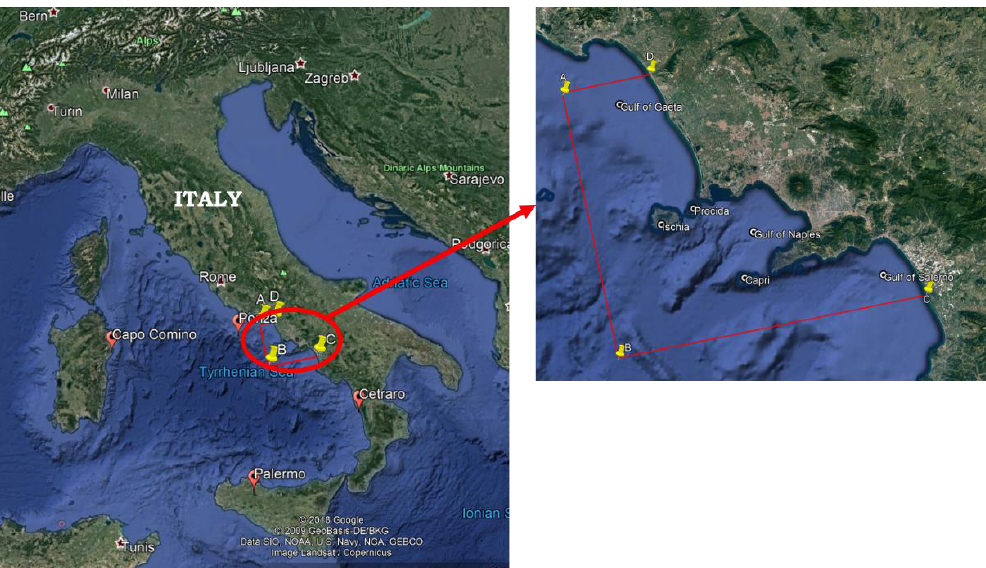
Figure 5. The area of interest is located in the South part of Italy. The red placemarks show the corners of the validation area of WRF-ARW wind model (left side). On the right side, there is a zoom on the test site, delimitated by red line, which includes the south of the Gulf of Gaeta, the Gulf of Naples with the Ischia, Procida and Capri Islands, and part of the Gulf of Salerno.